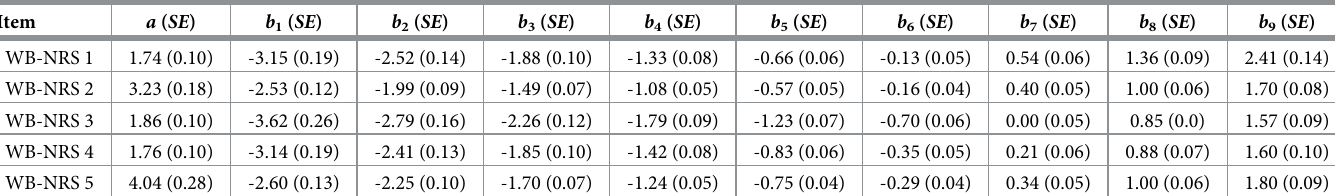
Table 2. Item response theory parameters of the Well-being Numerical Rating Scales (WB-NRSs).